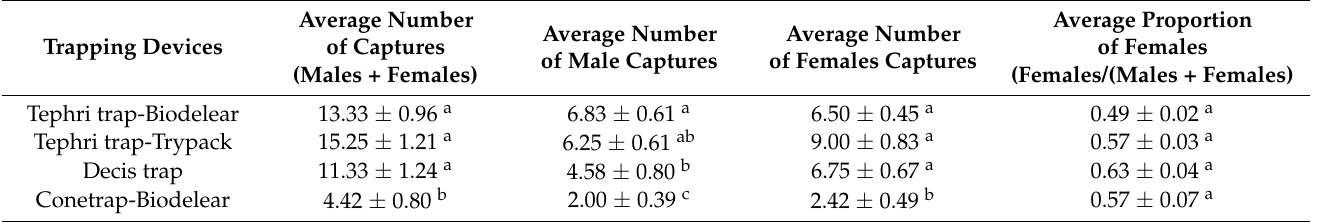
Table 2. Captures of medfly adults (±SE) and the proportion of females (±SE) in the four trapping devices.